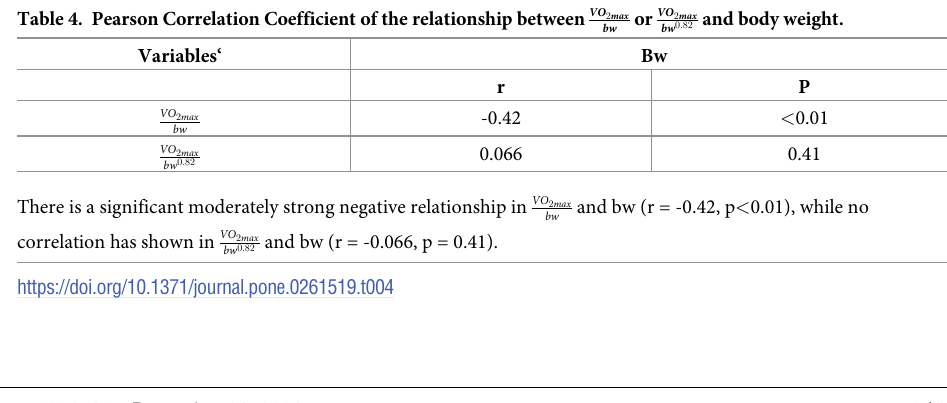
or VO 2 max and body weight. bw bw 0 : 82 r P -0.42 < 0.01 0.066 0.41 and bw (r = -0.42, p < 0.01), while no bw